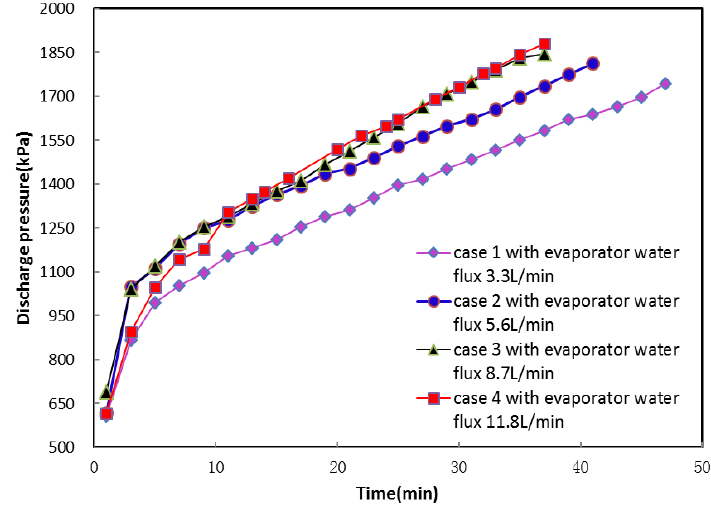
Figure 9. Compressor discharge pressures at different evaporator water fluxes.